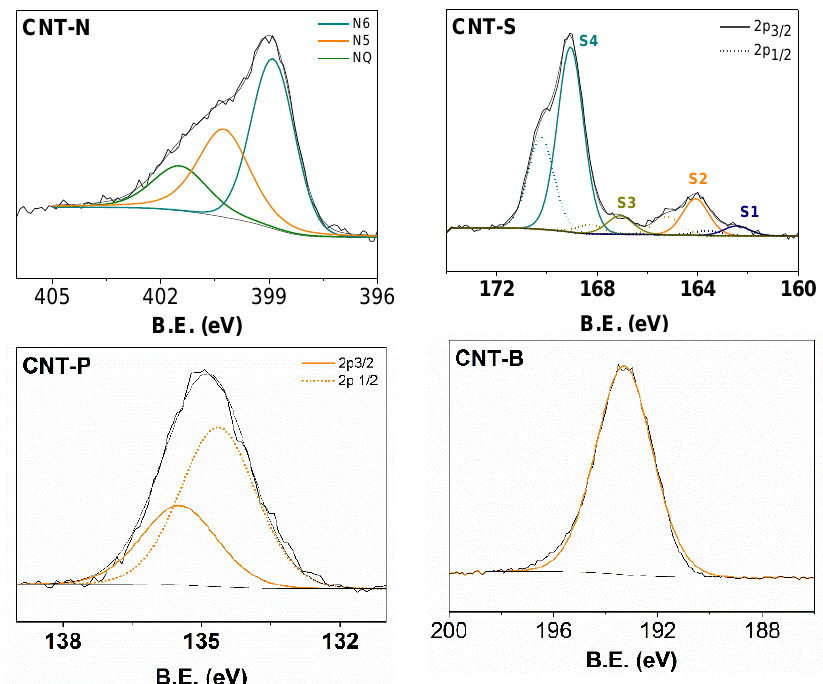
Figure 4. X-ray photoelectron spectroscopy (XPS) spectra recorded for samples carbon nanotube (CNT-N) (N1s), CNT-S (S2p), CNT-P (P2p) and CNT-B (B1s).